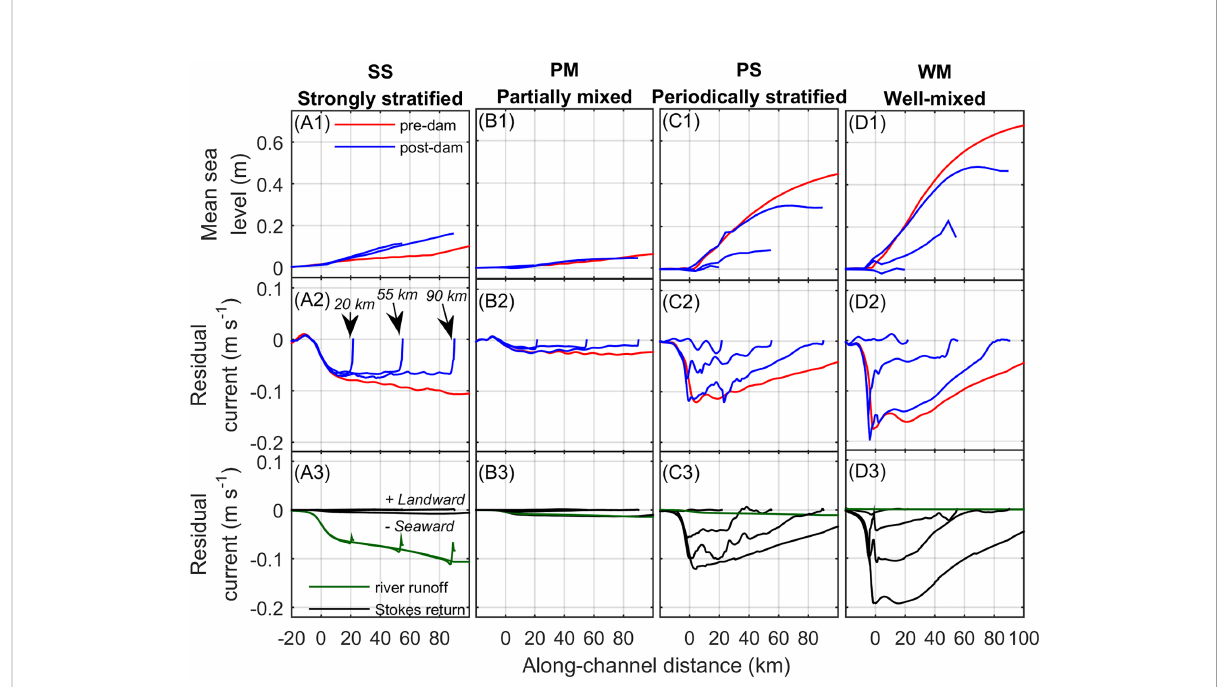
FIGURE 4 Pre-dam and post-dam along-channel pro fi les of (A1-D1) mean sea level (m), (A2-D2) cross-sectionally averaged Eulerian residual currents (m s -1 ), and (A3-D3) river runoff (m s -1 ) and Stokes return fl ow (m s -1 ) depending on estuarine dam location (dam at x = 20, 55, and 90 km). Along- channel distance is distance from the estuarine mouth, positive landward. Negative current is seaward. All results correspond to scenarios with discharge intervals D t = 3